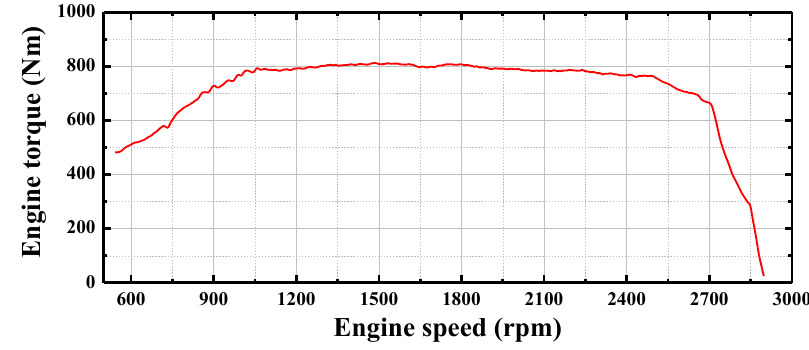
Figure 1. Sample of maximum torque date [12].